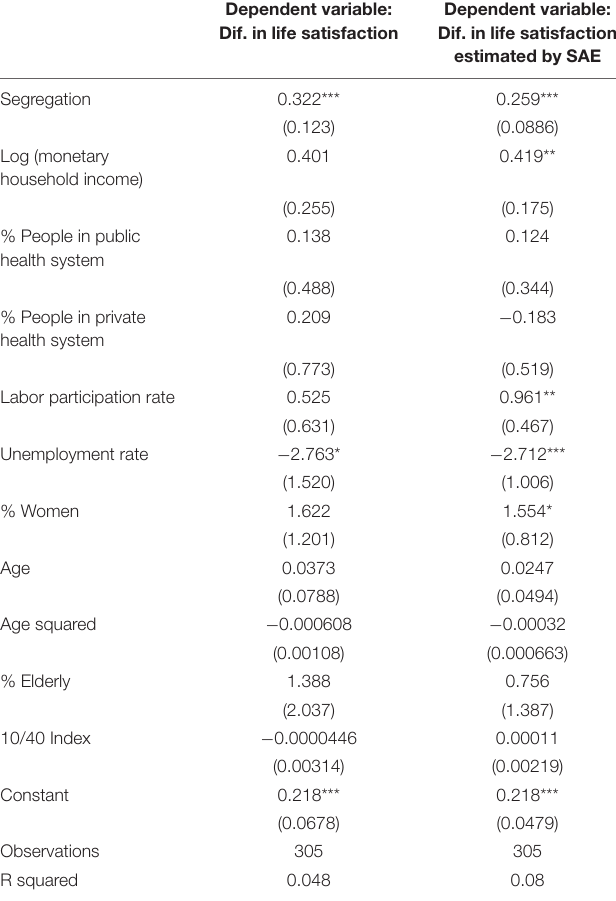
TABLE 5 | Determinants of life satisfaction (model in differences